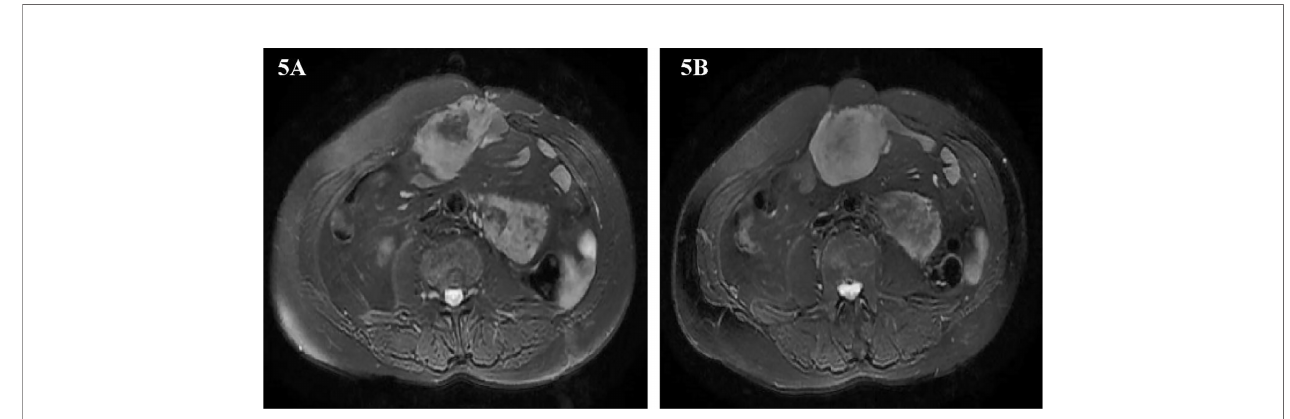
FIGURE 5 | (A, B) Abdominal image before the fi fth operation.